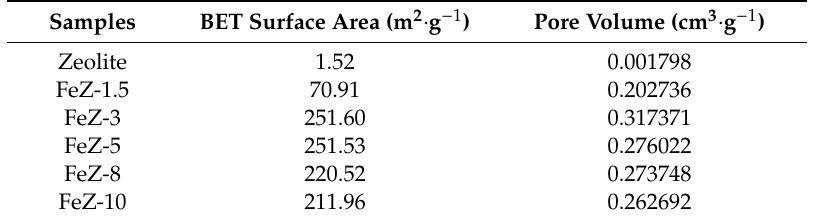
Table 2. Surface area and pore volume of bare zeolite and FeZ composites.